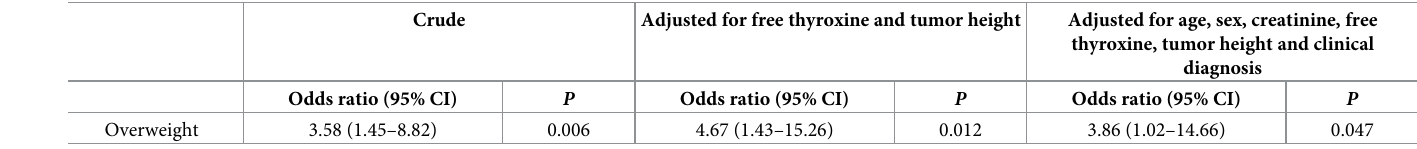
Table 3. Association between overweight and severe GH deficiency. Crude Adjusted for free thyroxine and tumor height Adjusted for age, sex, creatinine, free Odds ratio (95% CI) Odds ratio (95% CI) P Odds ratio (95% CI) P Overweight CI, confidence interval; GH, growth hormone; BMI, body mass